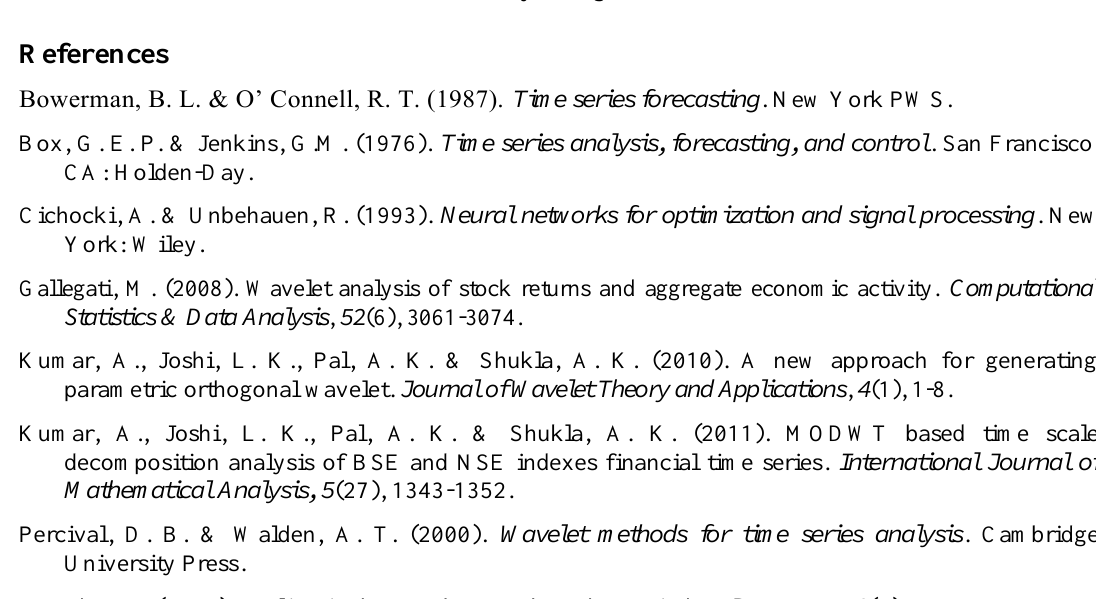
Table 2. Monthly average of NSE